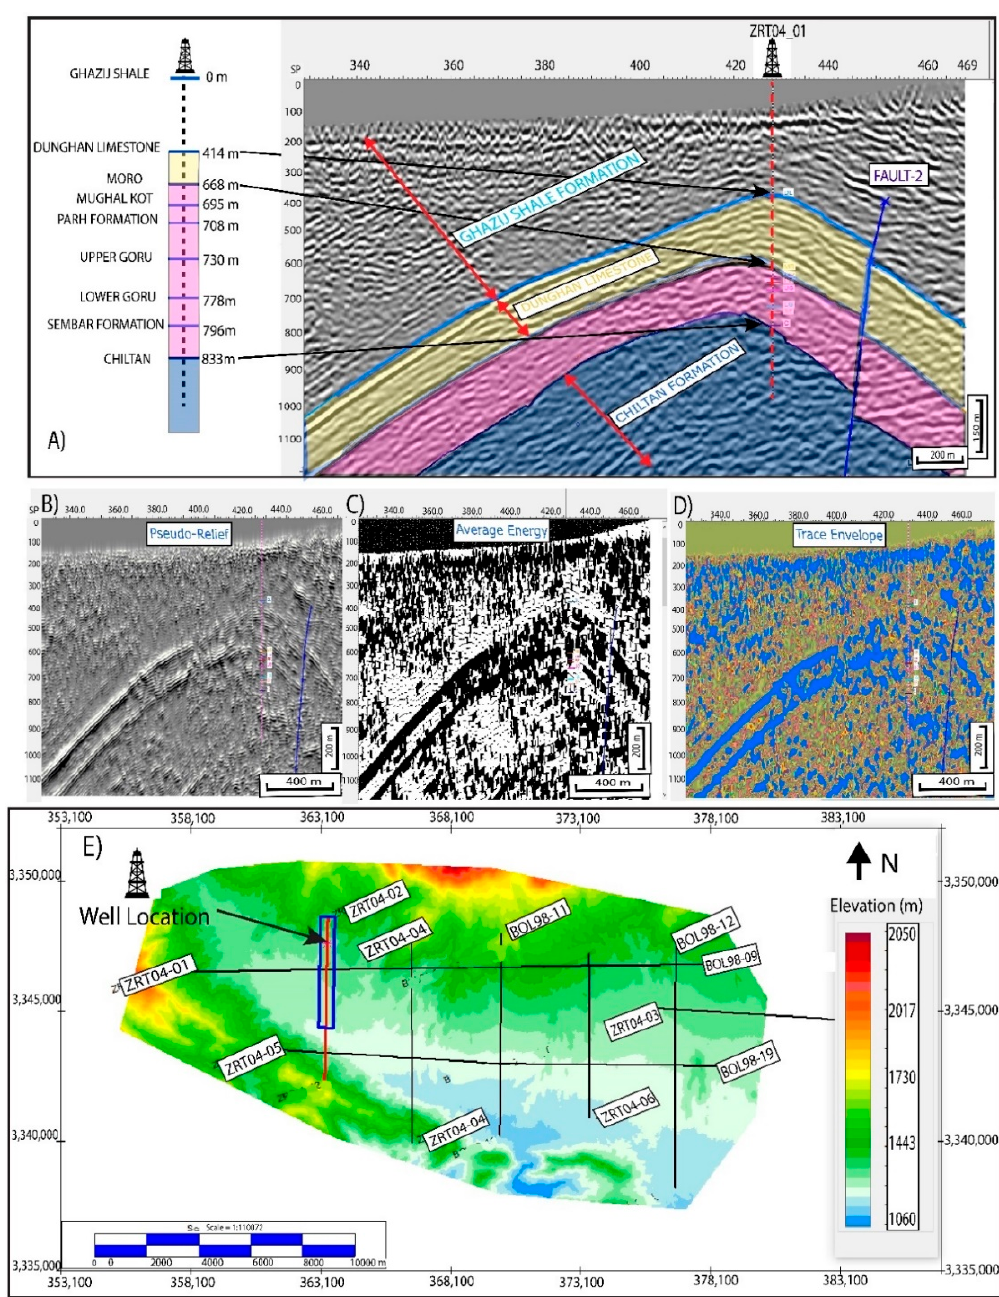
(Figure 10A). The well data show that the first 414 m represent the Eocene Ghazij Shale. The Paleocene Dunghan Limestone follows with a thickness of 254 m. Other stratigraphic intervals drilled include Moro, Mughal Kot, Parh, Upper Goru Formations that are Late Cretaceous in age, and the Lower Goru and Sembar Formation of the early Cretaceous. The deepest stratigraphic horizon drilled in Ziarat-01 well was the Middle Jurassic Chiltan Formation at a depth of 833 m.